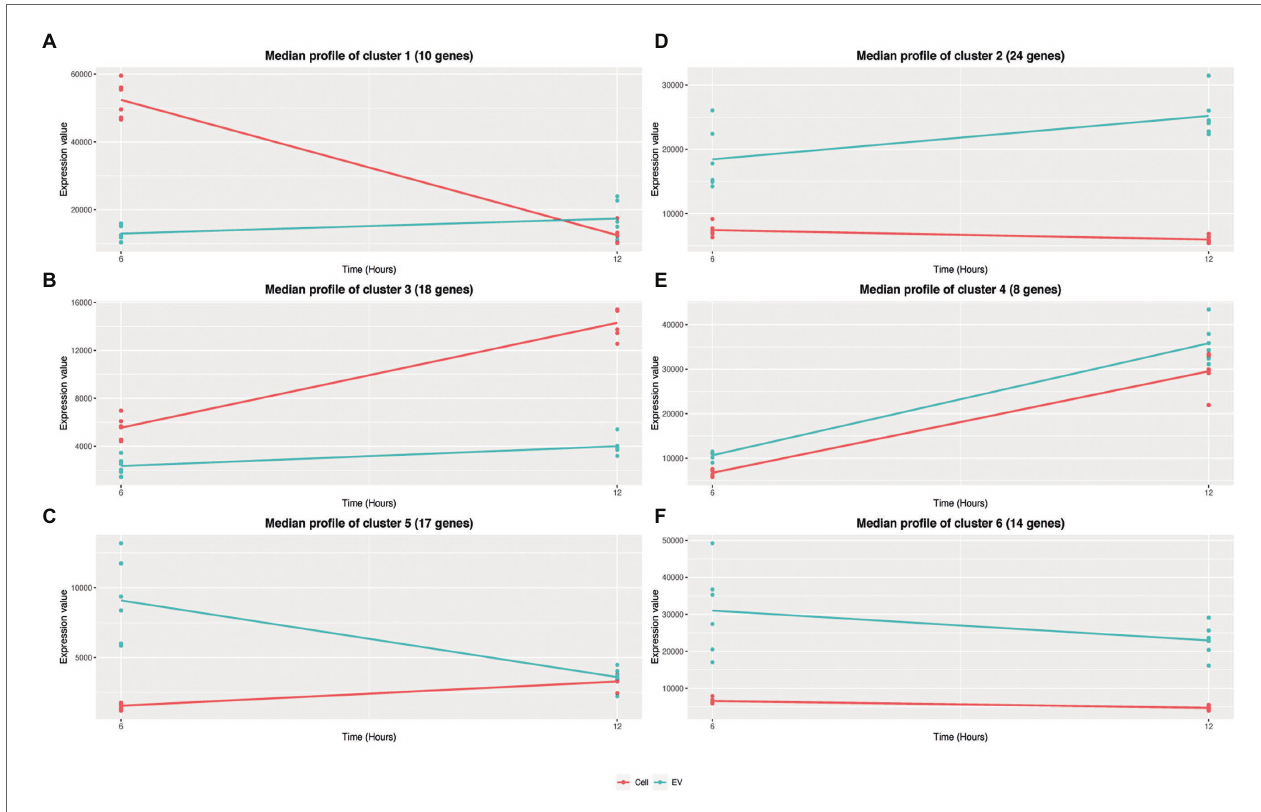
FIGURE 8 | Timepoint clustering of expression profiles between EVs and EV-producing cells. The analyses were performed with the R package maSigPro from normalized counts by EdgeR. Statistical significance ( p < 0.05) was adjusted with Benjamini-Hochberg method. Median expression values are calculated at 6 and 12 h for EVs (blue) and EV-producing cells (red) for the six clusters (from A to F